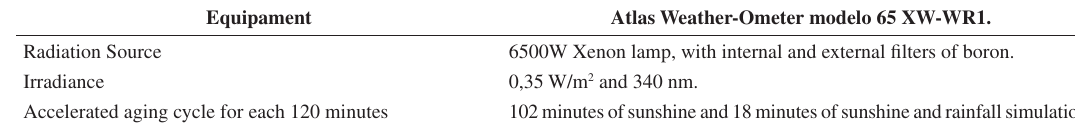
Table 3. Test conditions of accelerated aging by UV radiation, according to ASTM G-155-00 standard 21 .